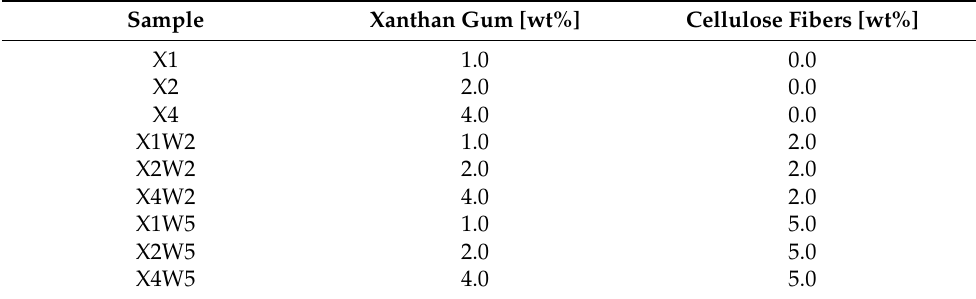
Table 2. List of the prepared hydrogel composites, used as SCs.